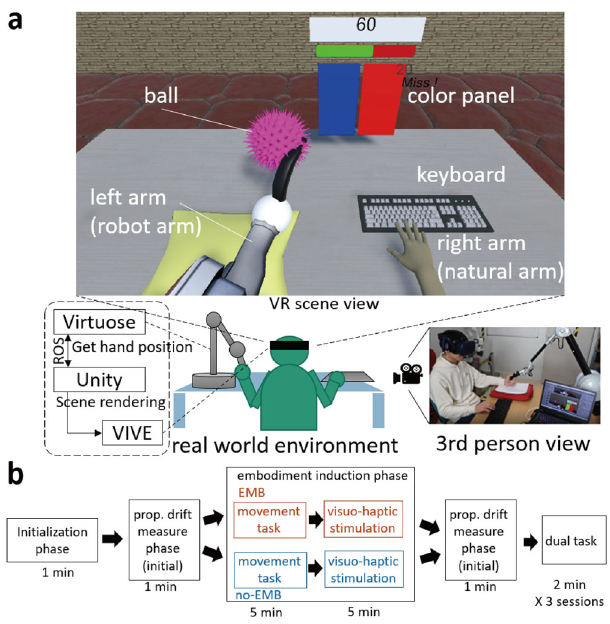
Fig. 1 Setup and paradigm of the experiment. a The participants performed the experiment in a virtual environment. They wore a head- mounted display and sat on a table with a keyboard under their right hand. They held the Virtuose haptic interface in their left hand. In the virtual environment, the participants observed a table and a right hand with the keyboard (upper panel). They saw a robot arm instead of their left arm. The robot left hand held a black banana-shaped object that was the shape of the handle of the haptic interface the participants held in their real left hand. hand/arm. b The participants worked in two conditions, EMB and